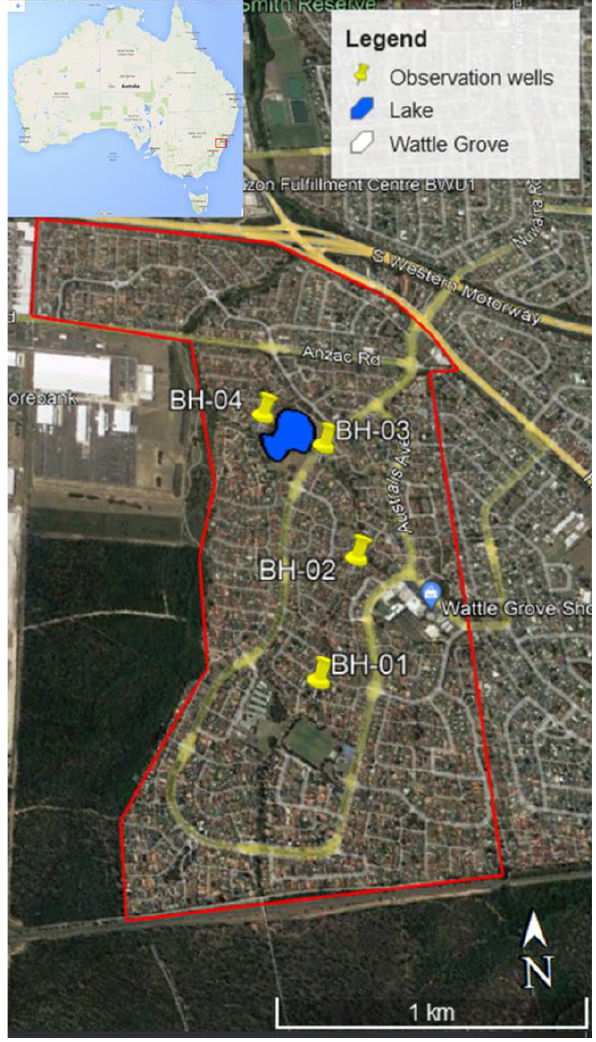
Figure 1. Study area map showing borehole locations and Wattle Grove Lake (adopted from [35]). Table 1. Borehole locations and